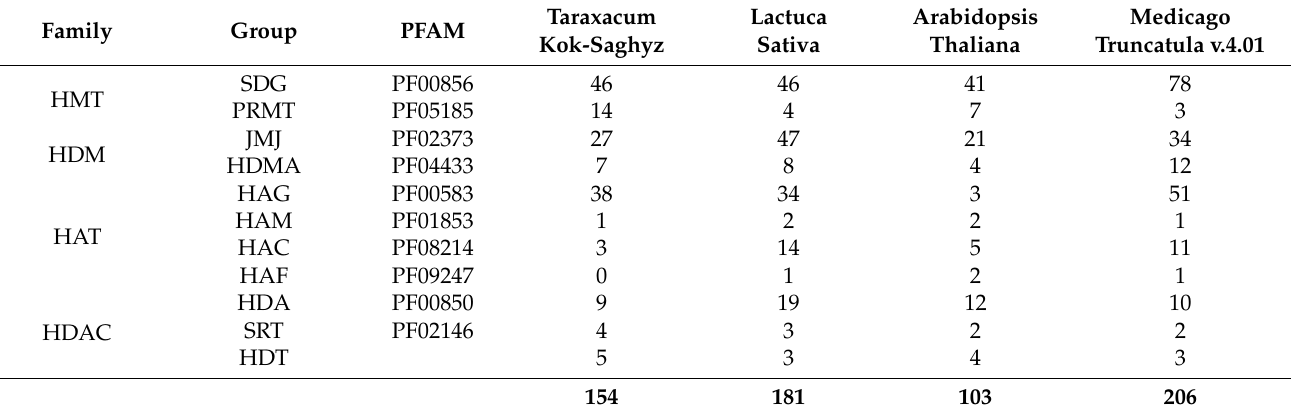
Table 1. Number of genes identified in the different classes of HMGs in Taraxacum kok-saghyz and in three reference species: Lactuca sativa , Arabidopsis thaliana , and Medicago truncatula